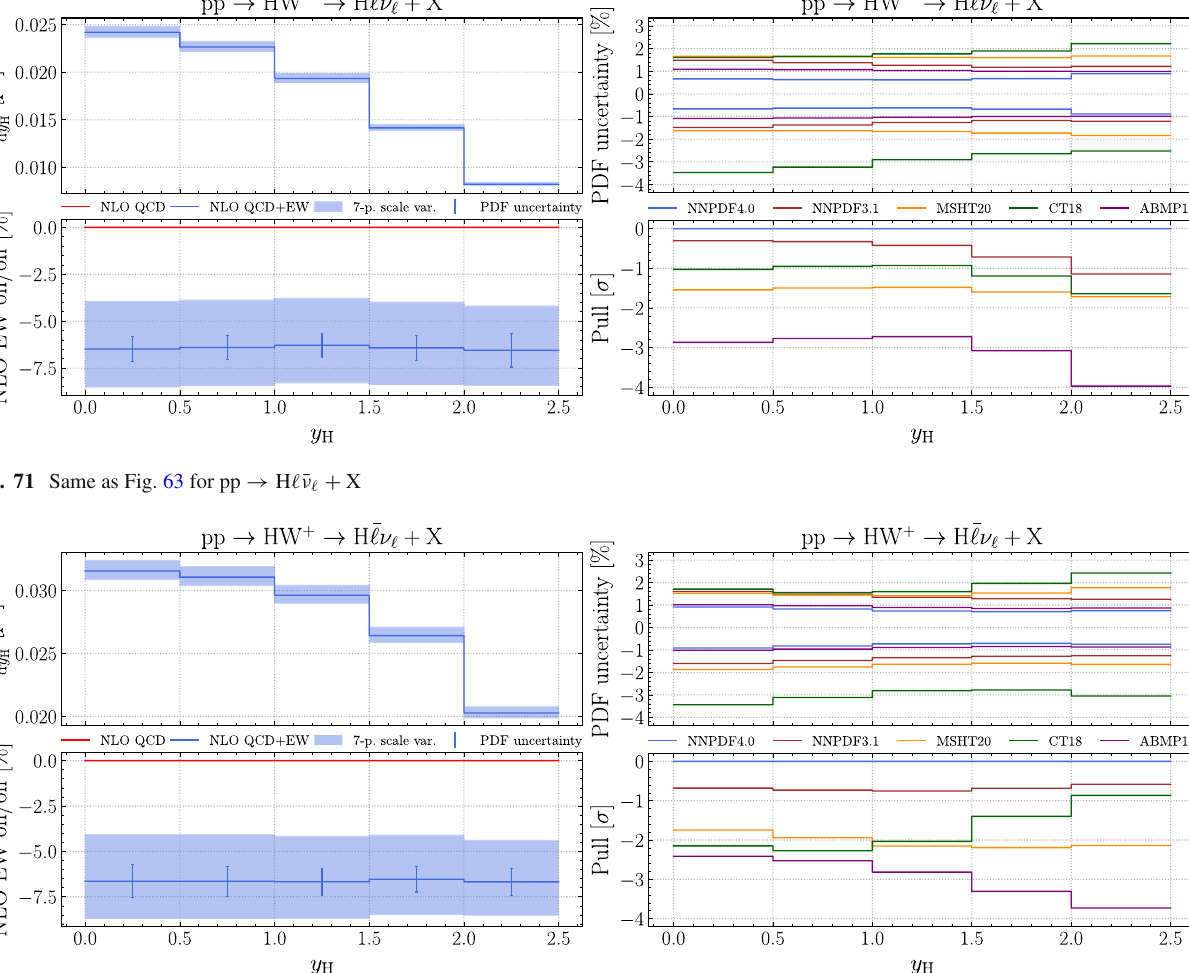
Fig. 72 Same as Fig. 63 for pp → H ¯ (cid:5)ν (cid:5) + X